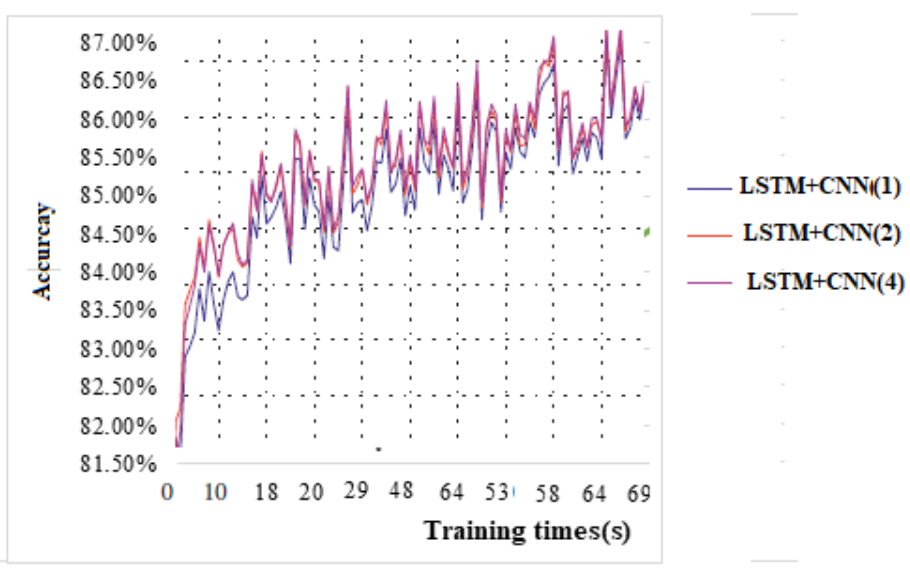
Figure 16. Study of the parameter ( β ) of training accuracy.